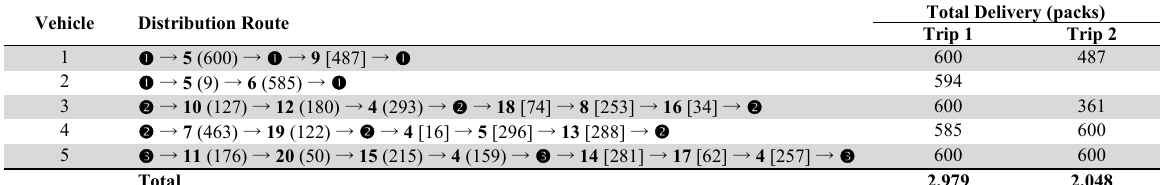
Distribution route and delivery of period 11 Vehicle